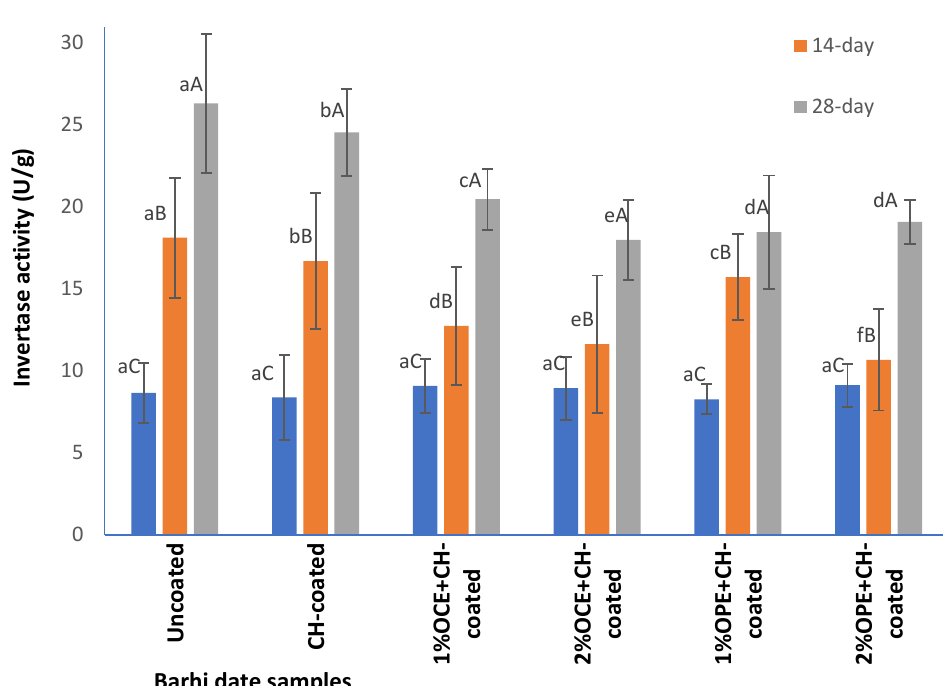
Figure 1. Invertase activity of Barhi dates coated with chitosan (CH) and/or olive-cake (OCE) or orange-peel extracts (OPE) during cold storage (4 °C) for 28 days. Values are means of triplicate samples (±SD) and represented by standard error bars. Same colored bars (same storage period) in different treatments not sharing a common lower-case superscript(s) a, b, c, d, e or f and different upper case letters A, B, or C within same treatment are significantly different at p ≤ 0.05 as assessed by Duncan’s multiple range test.